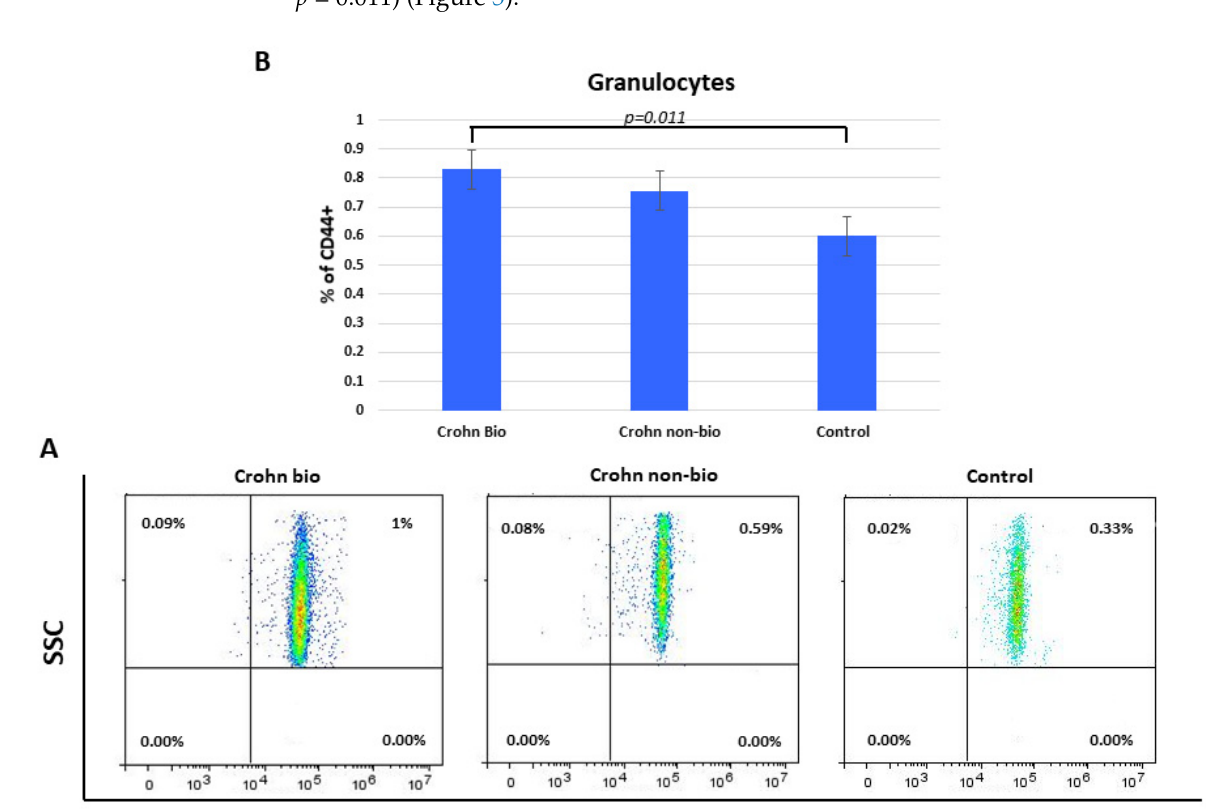
Figure 5. Percentage of CD44+ granulocytes in patients with Crohn’s disease. Representative dot plots ( A ) and statistical histogram ( B ) of patients treated with biological and non-biological therapy as well as of control subjects.